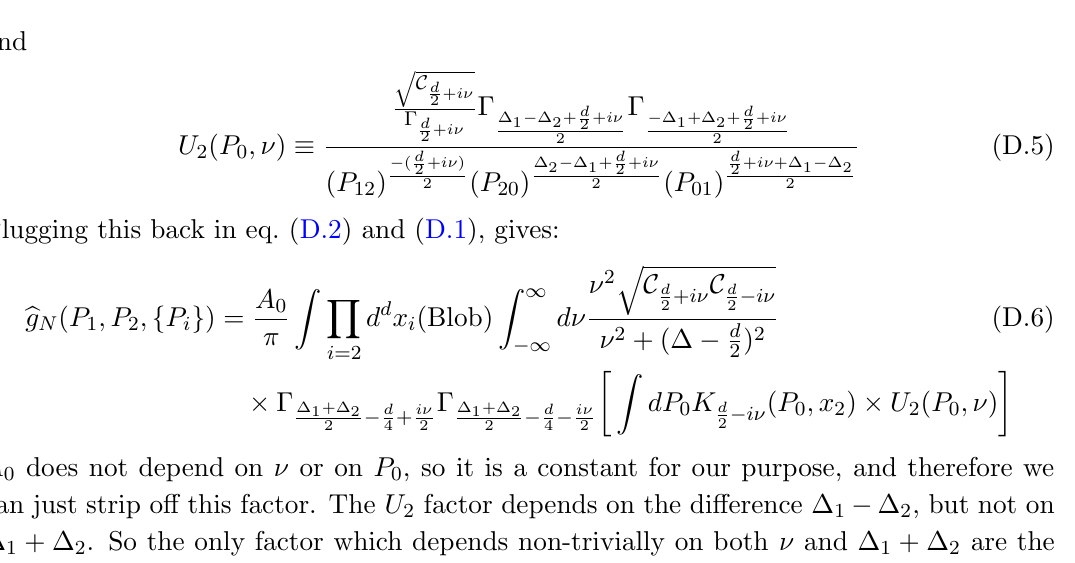
Figure 20 . Left: The 5-point tree-level exchange